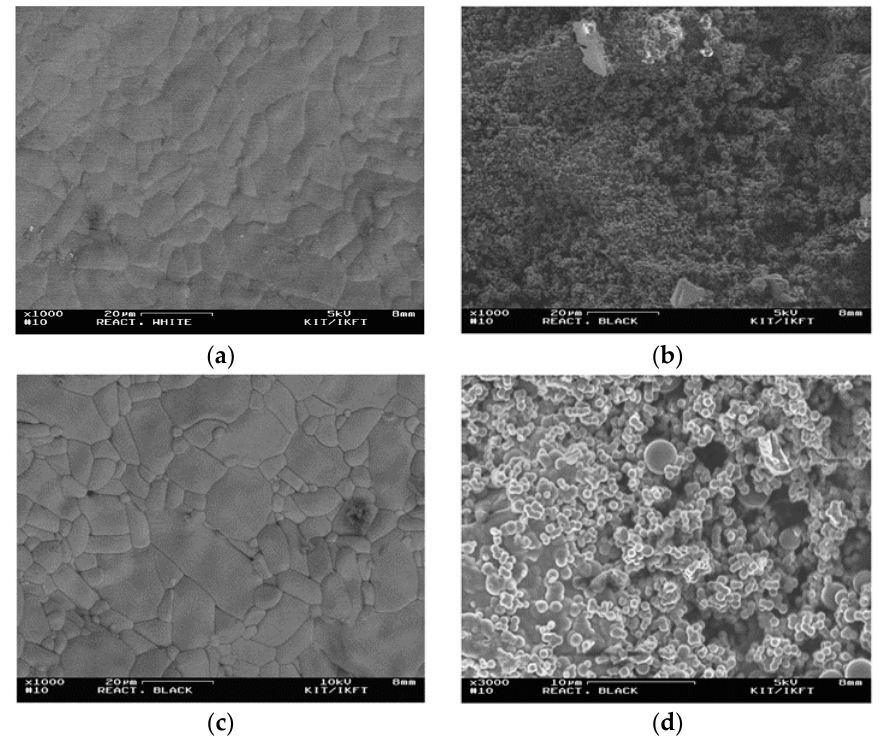
Figure 5. Scanning electron microscopy (SEM) image of the inner part of the ceramic inlay before and after the experimental campaign: ( a ) surface before the campaign (1000×); ( b ) surface after the campaign, black area (1000×); ( c ) surface after the campaign, white area (1000×); and ( d ) surface after the campaign, black area (3000×).